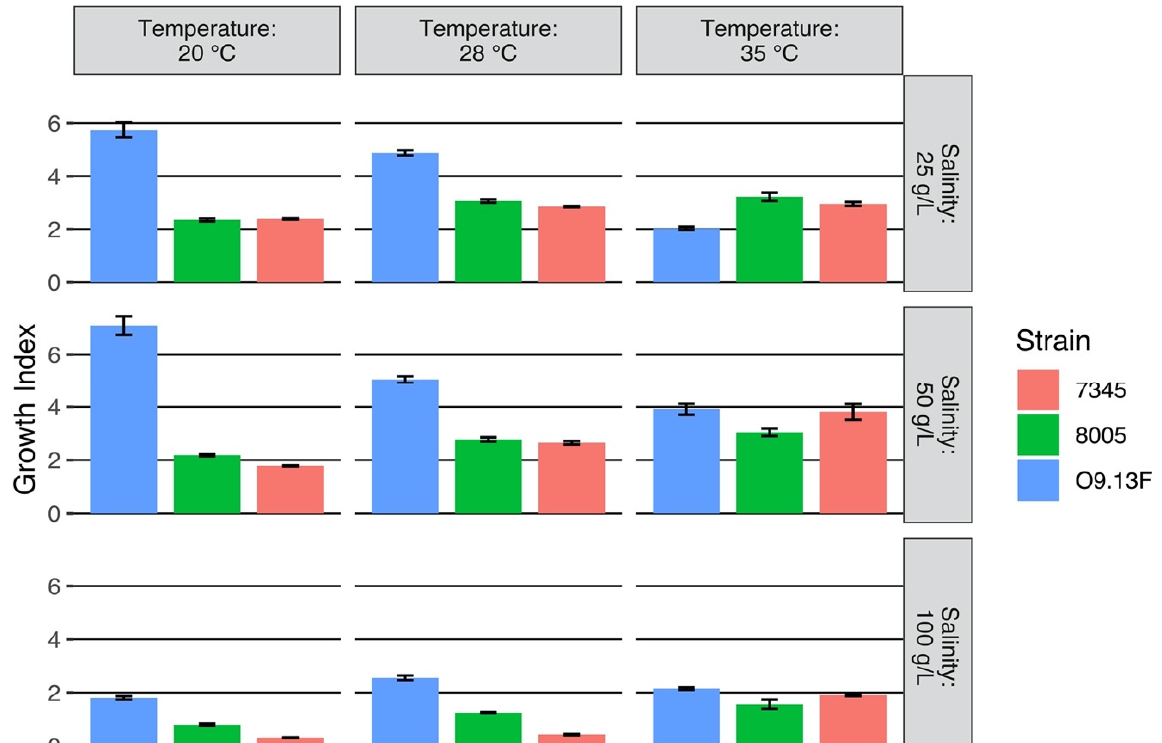
Figure 3. Effect of salinity (Zarrouk medium supplemented with NaCl to total salinity up to 25 g/L, 50 g/L, 100 g/L) on the growth of Arthrospira sp. strains, O9.13F, PCC7345 and PCC8005. Strains were grown for 8 days at different temperatures (20 °C, 28 °C and 35 °C). The optical density measurements were performed in triplicates for each strain in each of the conditions. The standard deviations are shown. The growth index is the quotient of the optical density [McF] of the culture after 8 days incubation and the optical density of the culture at the start point of the experiment.